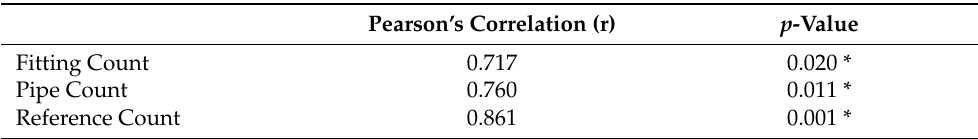
Table 6. Pearson’s correlation (r)—pipefitter interaction (visit count) by visual drawing complexity (number of fittings, pipes, and references) (N = 10).